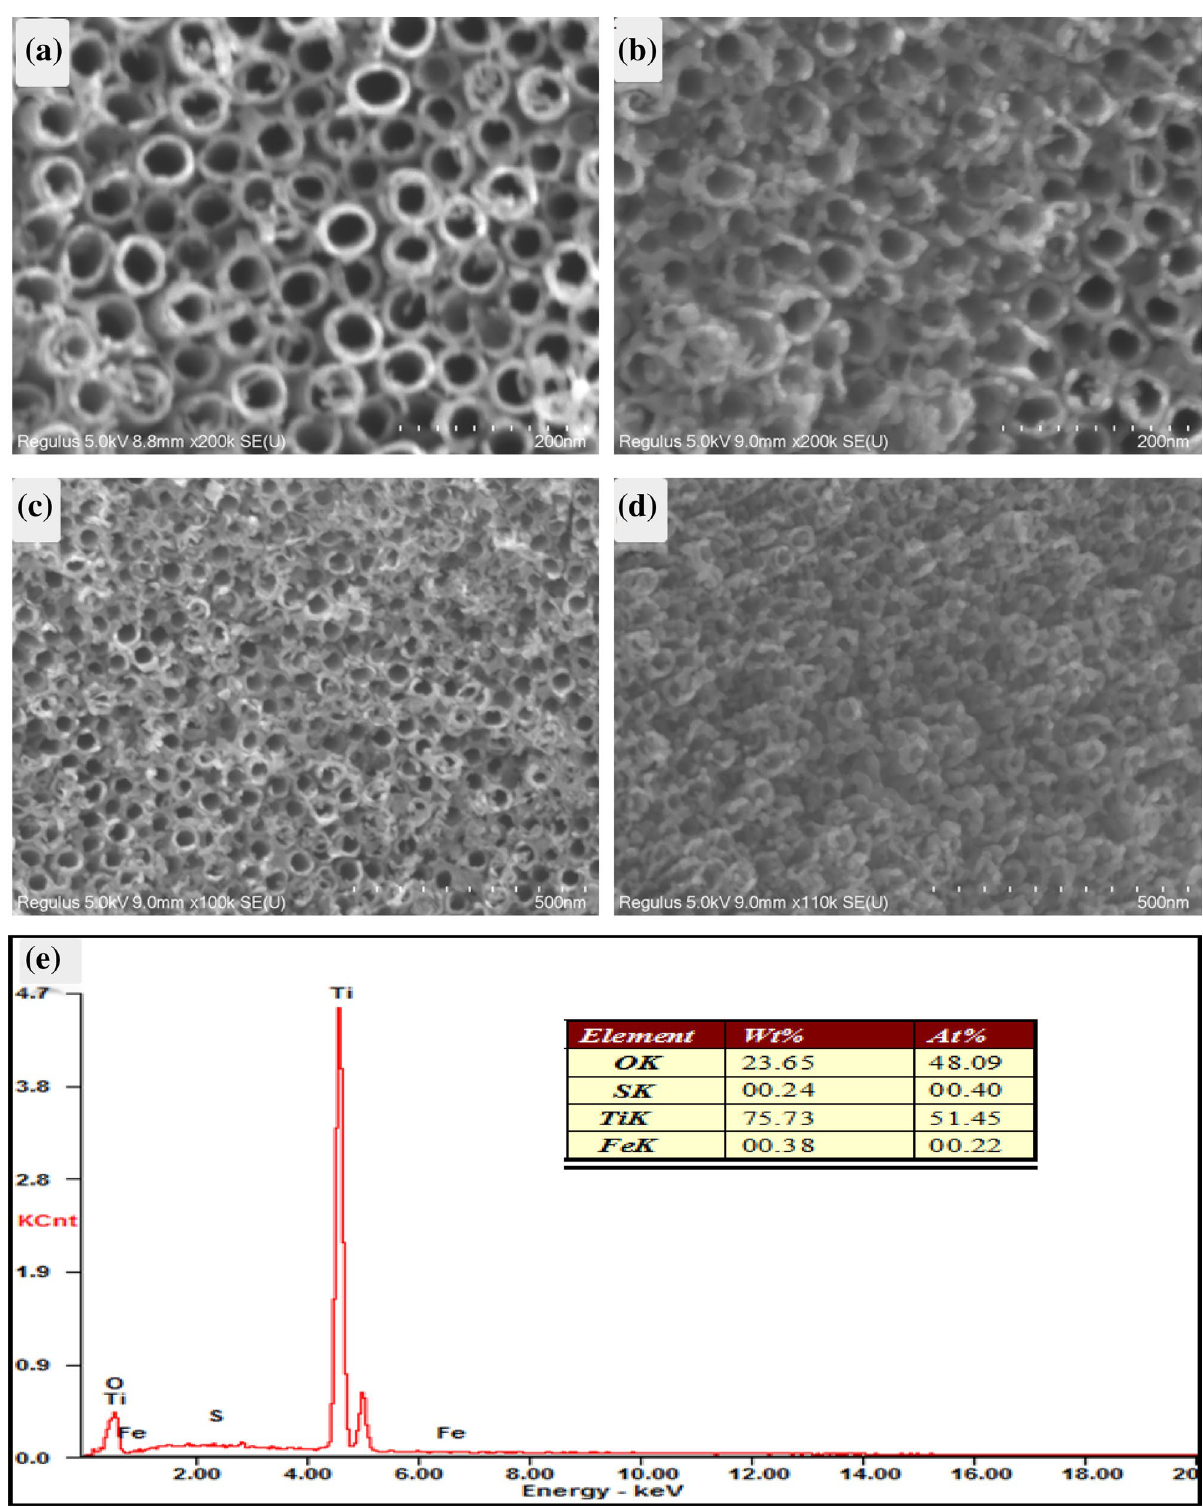
Figure 4. SEM images of ( a ) pure TiO 2 , ( b ) 5-FST, ( c ) 10-FST, ( d ) 20-FST; ( e ) EDS of